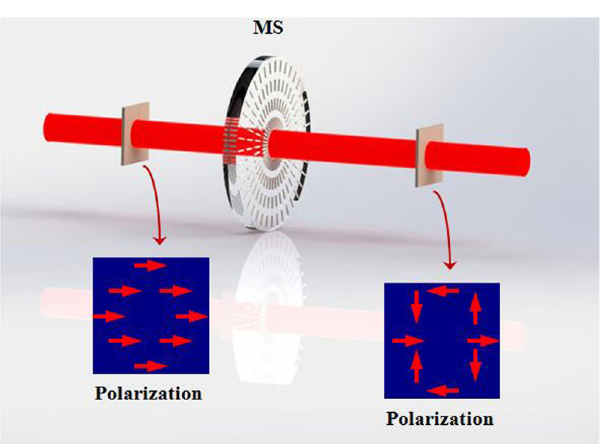
Figure 5. Measured intensity profiles by using the combinations of a QWP and a GL. The second row and third row show the measurement results of LCP (topological charges ( l ) was − 2) and RCP (topological charges ( l ) was + 2) VBs, respectively. Two axis orientations of polarizer 0° and 90° (blue arrows in the first row) are selected in experiment.